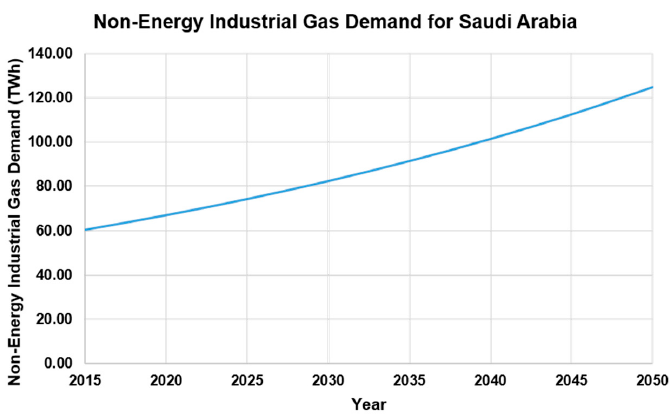
Figure 6. Industrial gas demand projection for Saudi Arabia from 2015 to 2050 [52].